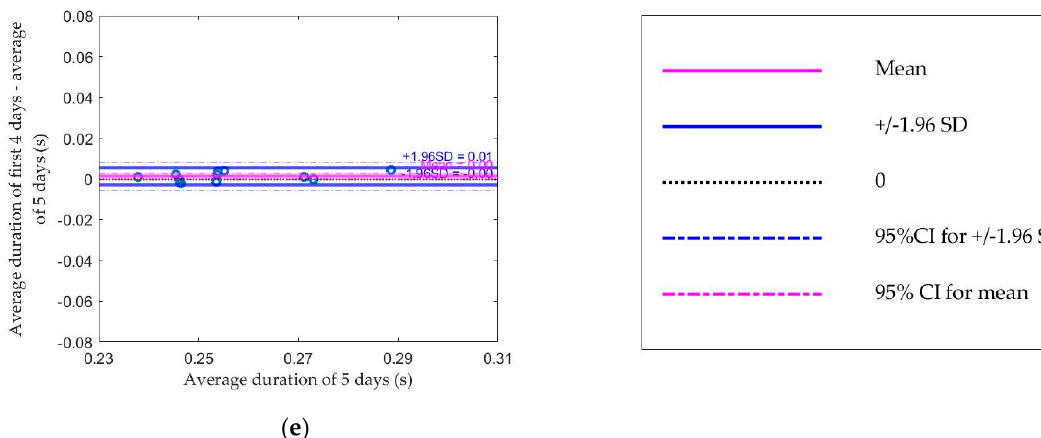
Figure 2. ( a ) Average leg movement duration from the first day to the fifth day for each infant; Bland–Altman plots comparing ( b ) the first day, ( c ) the average of the first 2 days, ( d ) the average of